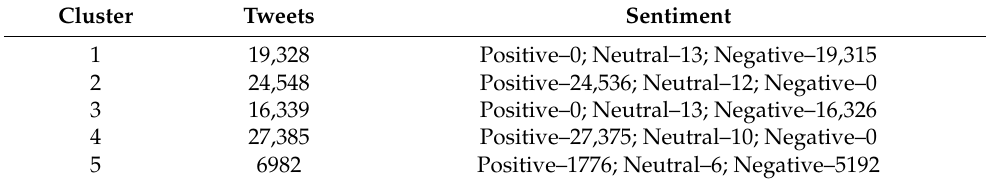
Table 5. Number of Tweets in Each Cluster.